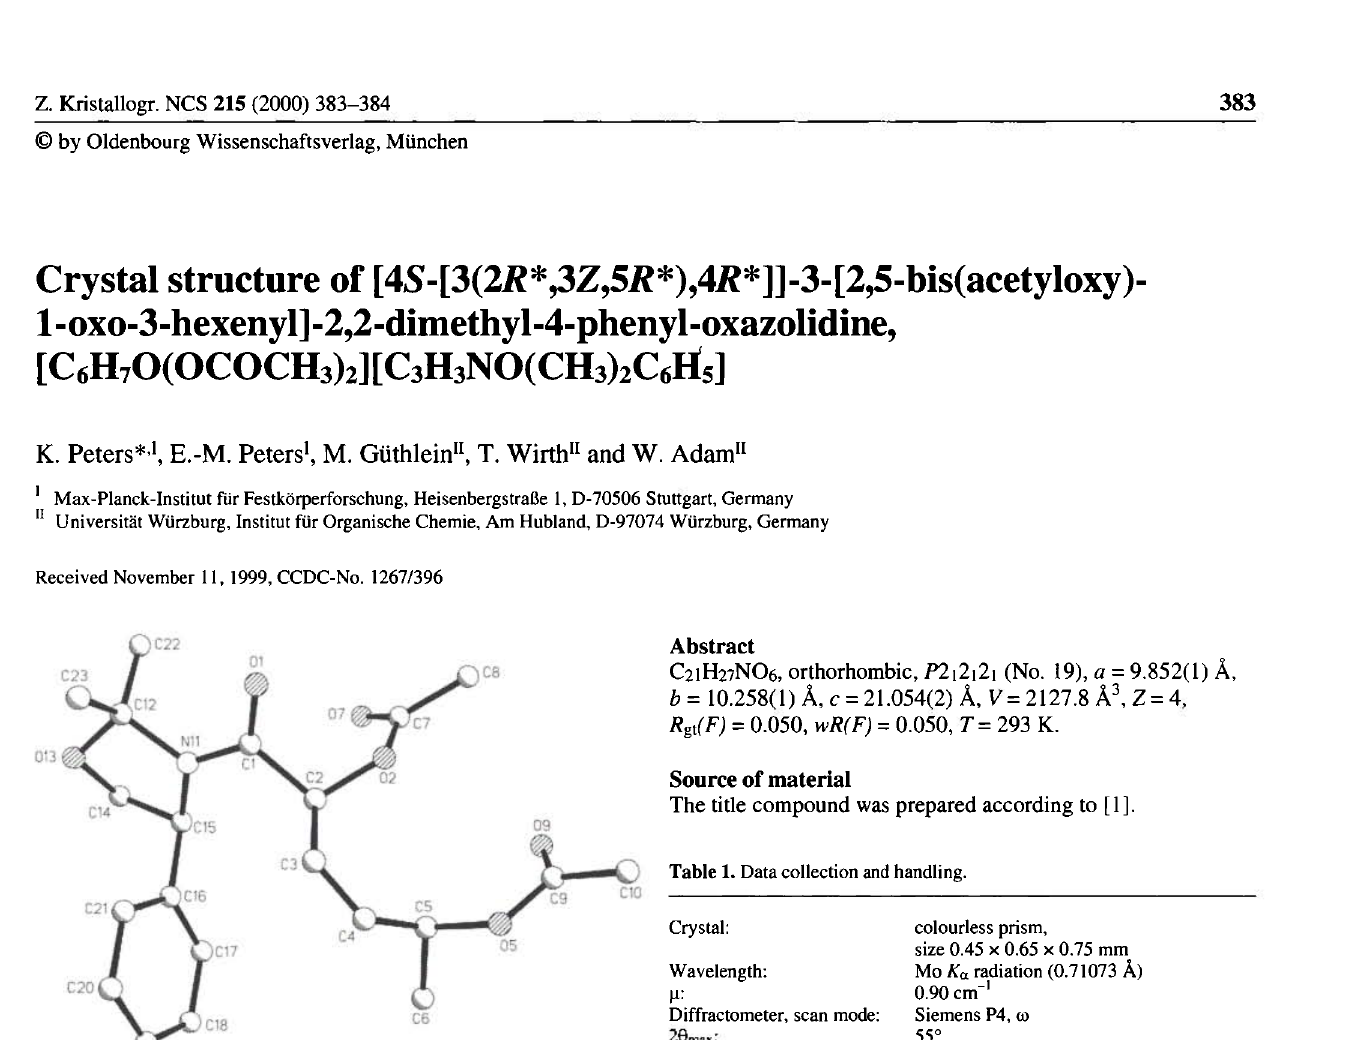
Table 2. Atomic coordinates and displacement parameters (in Ä 2 ). Table 2.